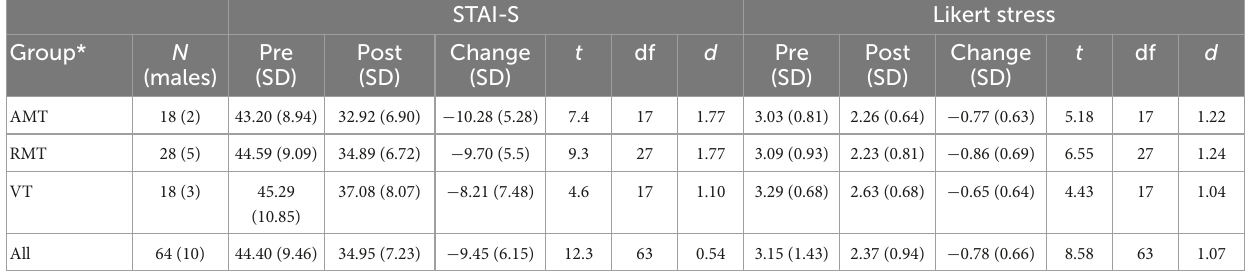
TABLE 1 Change in stress and anxiety scores pre to post sessions (for each participant, their pre-score minus post-score was averaged across sessions). STAI-S Likert